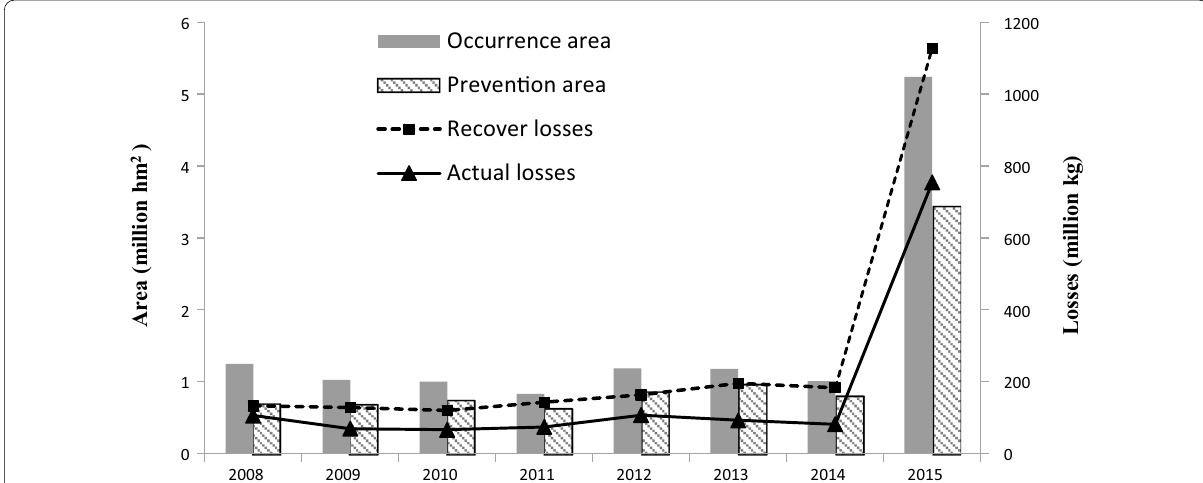
Fig. 3 The occurrence area and prevention area of southern corn rust, and actual losses and recover losses of maize in China during 2008–2015 (Liu et al. 2016)